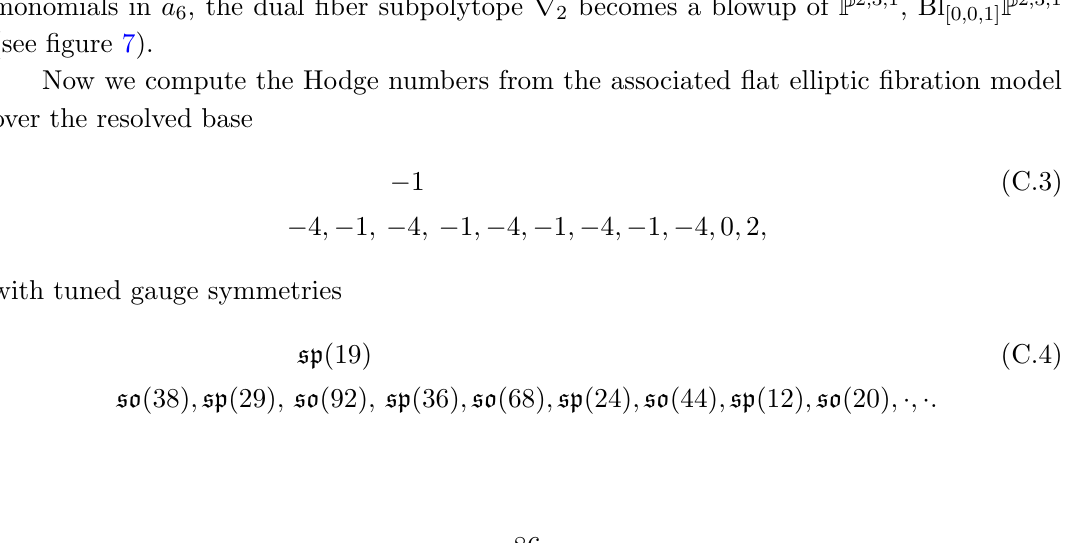
Figure 7. The re(cid:13)exive polytope pair for the Bl